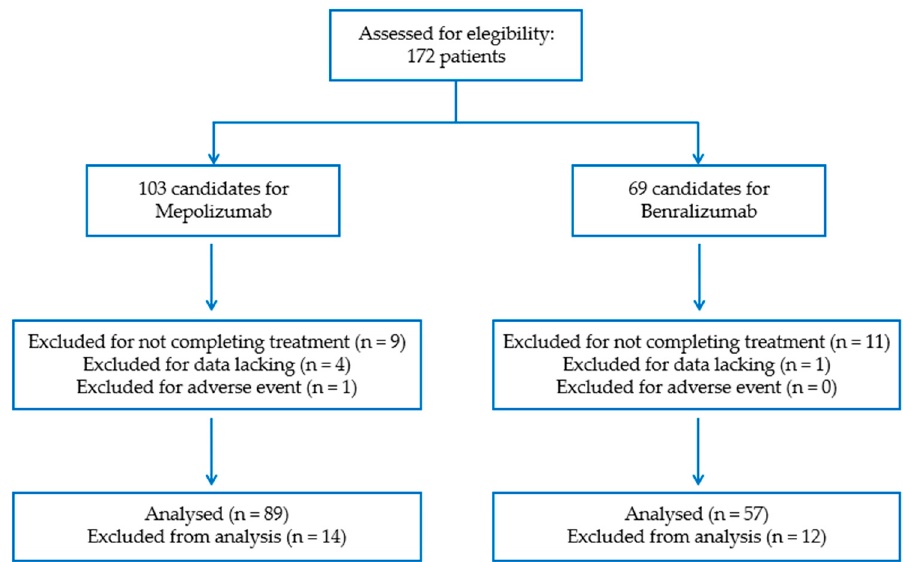
Figure 5. Patient eligibility